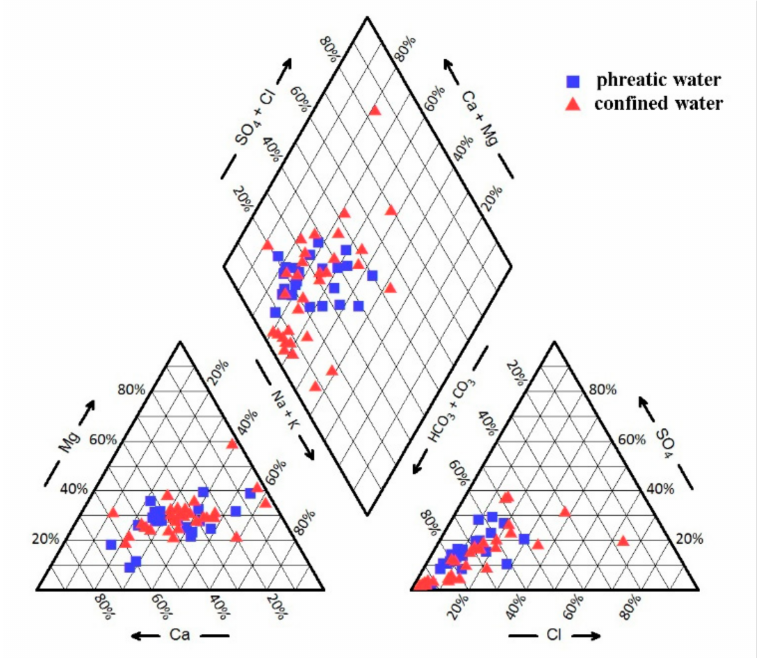
Figure 4. Piper diagram of groundwater samples in the study